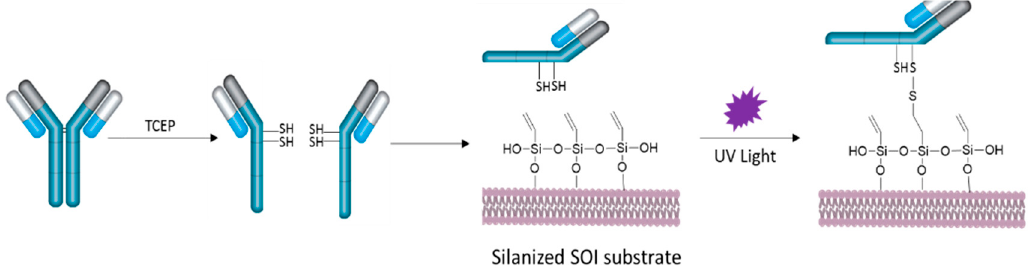
Figure 2. Schematic representation of the process used for the UV light-assisted covalent immobilization of the half anti-bovine serum albumin (haBSA) on the SOI sensors surface.